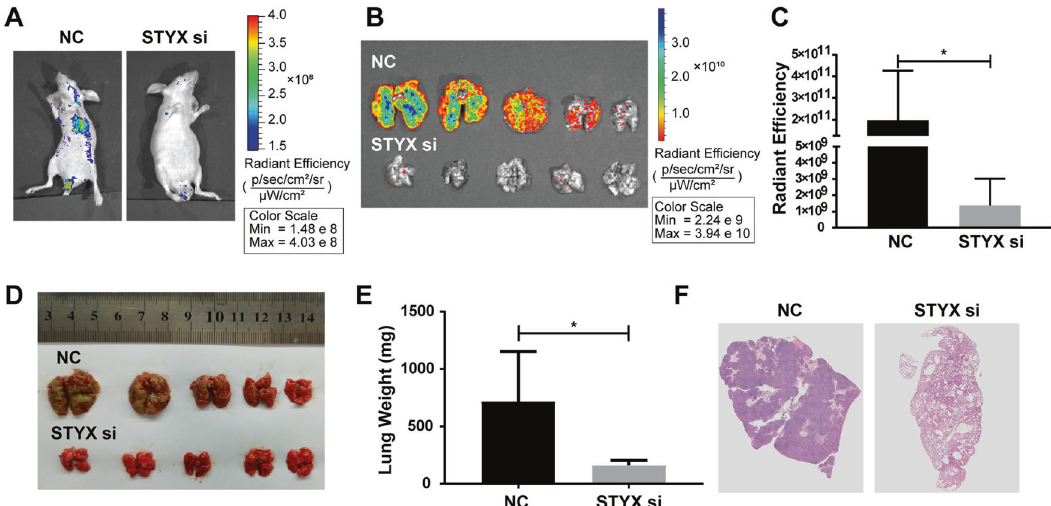
Fig. 4 STYX affects the tumor metastasis of GC in vivo. A, B BGC-823 cells with negative control (NC) or stable knockdown of STYX (STYX si) were injected into the tail vein of the nude mice. The effect of STYX knockdown on the lung tumor metastasis was detected by bioluminescent images. Representative images of the whole mice or the lung were shown. C Quanti fi cation and statistical analysis of the bioluminescence imaging in the lung region. The data are expressed as the means ± SD. D Representative images of lung metastasis were shown. E Statistical analysis of the lung weight of mice injected with different cells. Data were expressed as the means ± SD. F H&E staining of lung tissues was used to detect the metastasis nodules. Representative images were shown.